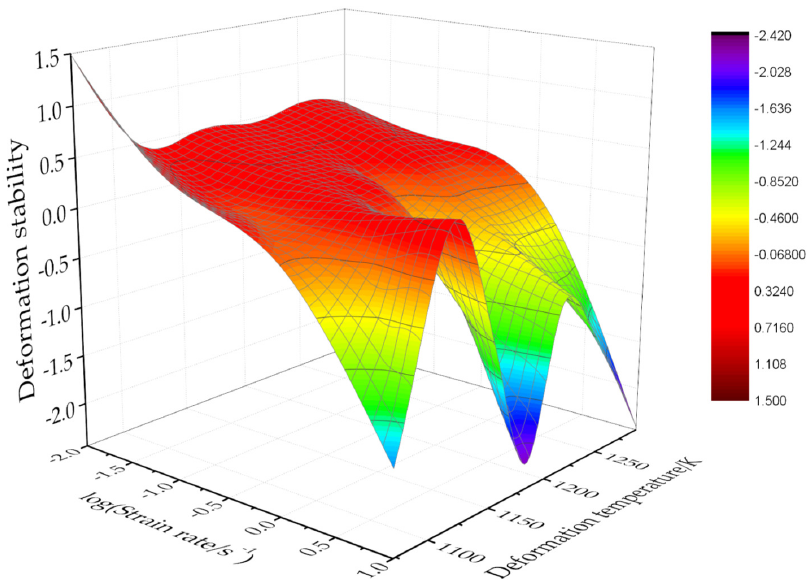
Figure 13. Instable map of the isothermal compression of the Ti–3.3Al–1.5Zr–1.2Mo–0.6Ni alloy.